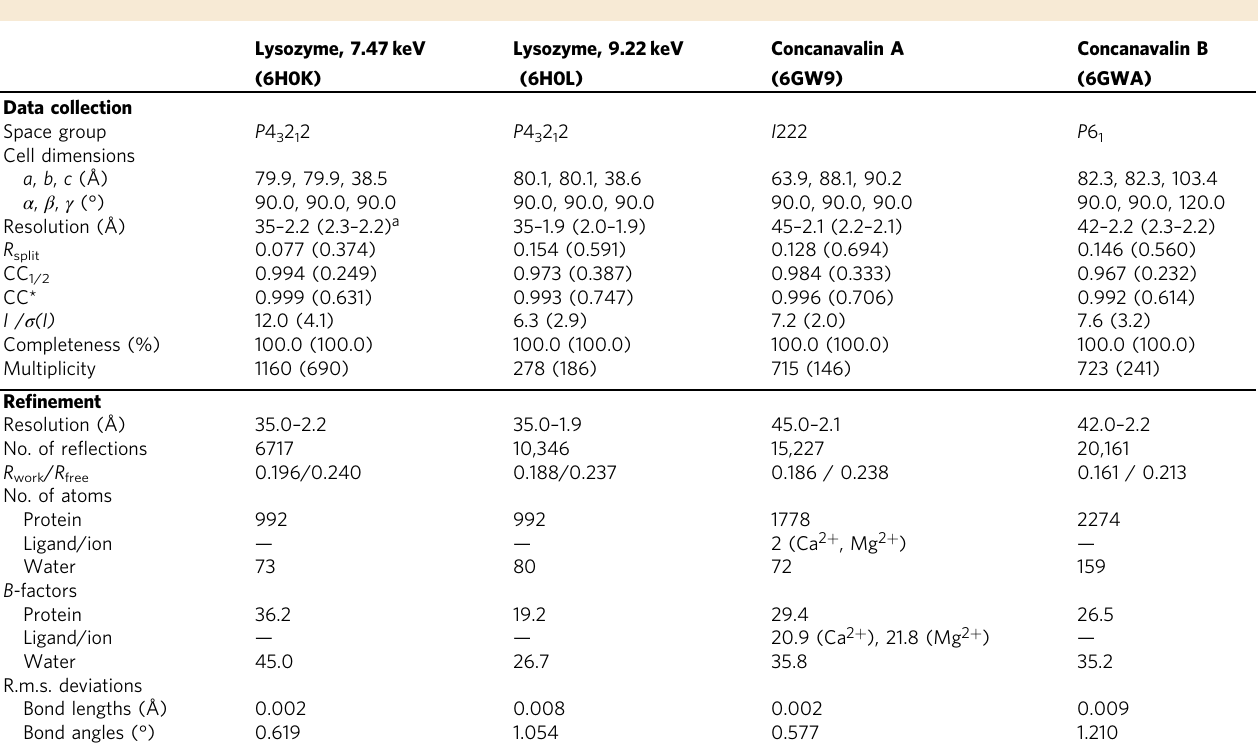
Table 1 Data collection and re fi nement